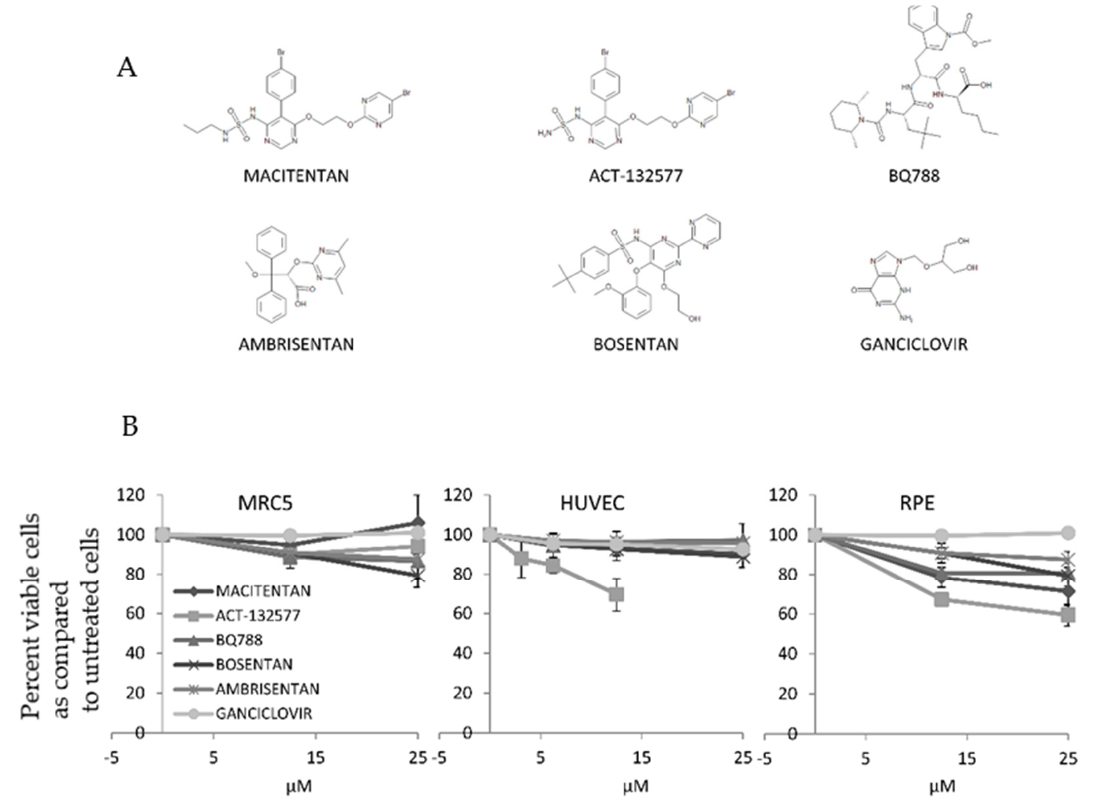
Figure 1. ETR antagonists are not toxic at low concentrations. HUVECs, MRC5, and RPE-1 cells were exposed to various concentrations of macitentan, ACT-132577, BQ788, ambrisentan, bosentan, or ganciclovir. ( A ) Chemical structures of the compounds. ( B ) Cells were treated with the compounds for 7 days, whereafter cell viability was quantified and normalized to untreated cells. ETR antagonists were not toxic for HUVECs, MRC5, and RPE-1 cells at low concentrations. Values are mean ± SD of triplicates. Table 1. Treatment of HCMV infected MRC-5, HUVEC and RPE cells with ETR Antagonists or Ganciclovir at different concentrations and cellular viability was quantified.